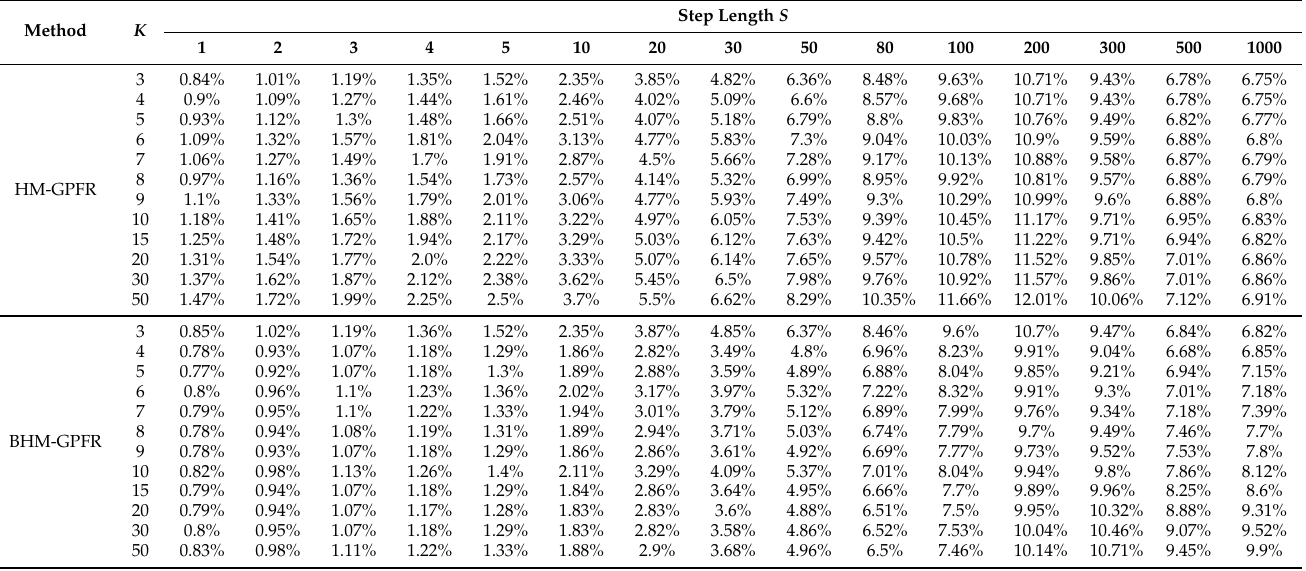
Table 3. Sensitivity of HM-GPFR and BHM-GPFR with respect to the number of components K